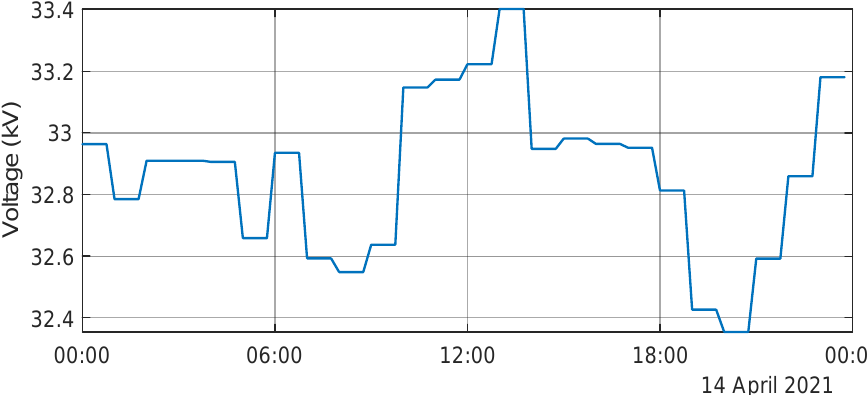
Figure 5. Measured voltage profile at the 33 kV side of the Xewkija DC transformer.